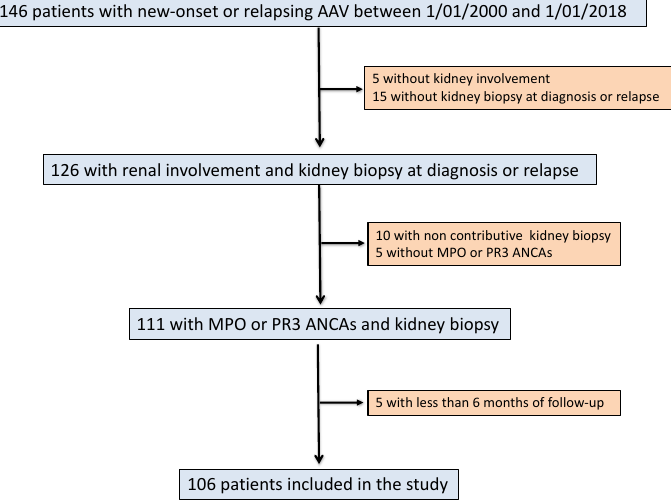
Figure 1. Flowchart of the study. AAV, ANCA-associated vasculitis; ANCA, antineutrophil cytoplasmic antibody; MPO, myeloperoxidase; PR3, proteinase-3. Table 1. Main characteristics of patients with connective tissue diseases (CTD).